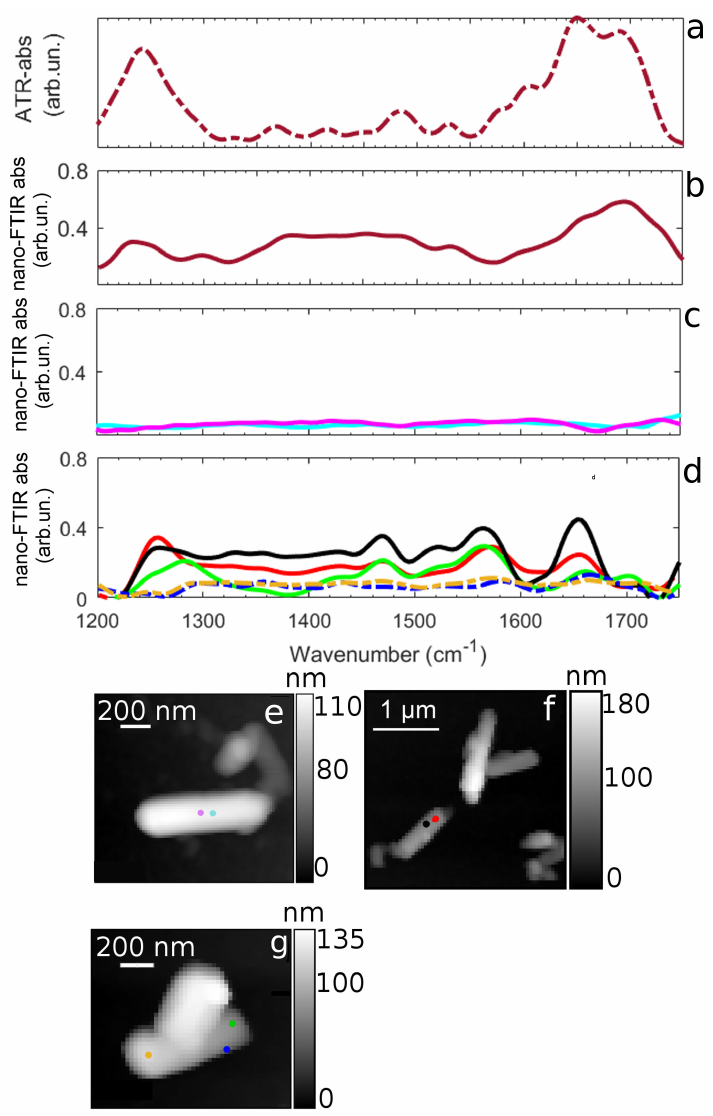
Figure 3. ( a , b ) ATR-FTIR (red dotted-line) and Nano-FTIR (red solid line) DNA absorption in the spectral region 1200–1750 cm − 1 . ( c ) Nano-FTIR absorptions at two distinct spatial points of HNs in the spectral region 1200–1750 cm − 1 . ( d ) Nano-FTIR absorptions at distinct spatial points of DNA– HNs in the spectral region 1200–1750 cm − 1 . ( e – g ) AFM images showing HNs ( e ) and DNA–HNs ( f , g ) nanotubes. Purple and light blue dots on AFM image at panel ( e ) correspond to the positions at which the spectra in panel ( c ) were acquired. Black and red dots on AFM image at panel ( f ) correspond to the positions at which the spectra of same colors reported in panel ( d ) were acquired and green, orange and blue dots on AFM image at panel ( g ) correspond to the positions at which the spectra of same colors reported in panel ( d ) were